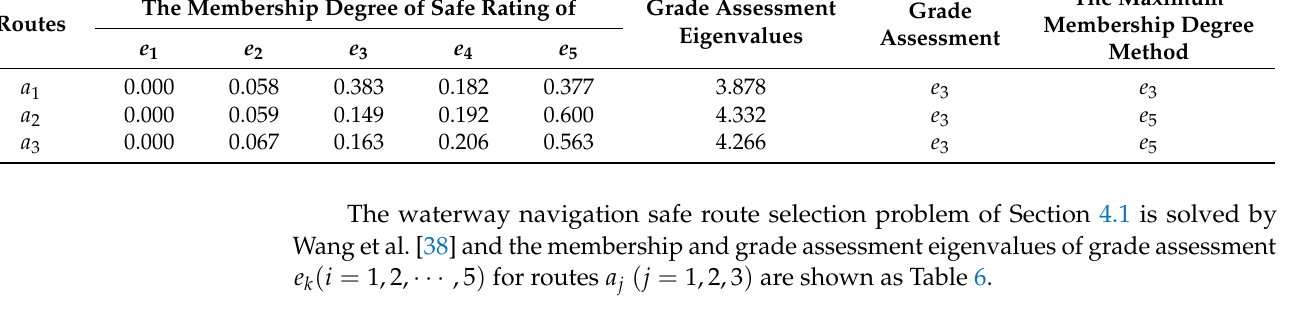
Table 6. Results for grade assessment of waterway navigation safe